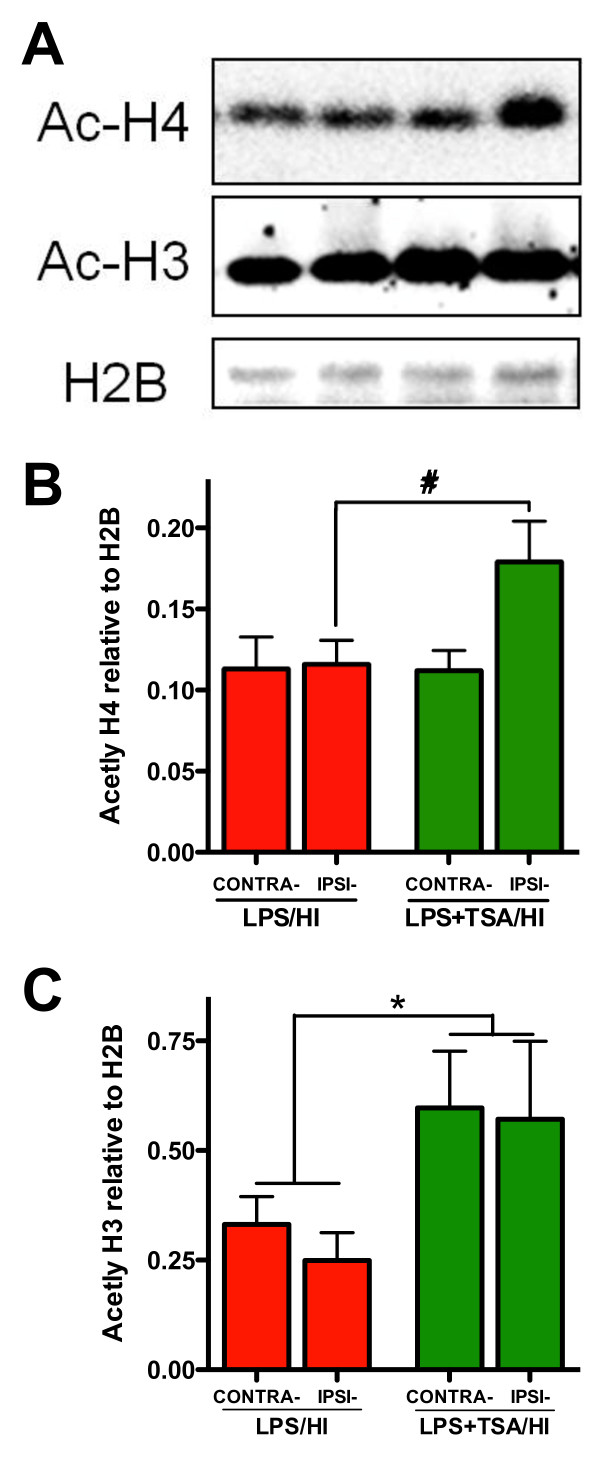
Trichostatin A (TSA) persistently increases histone acetylation at 24 hours after injury. (A) Western blots of acetylated histone-4(Ac-H4), acetylated histone-3 (Ac-H3, molecular weight 17 kDa) and reference protein H2B in female lipopolysaccharide-sensitised hypoxiaischaemia (LPS/HI) mice (red bars) and LPS + TSA/HI mice (green bars) 24 hours after injury. (B) and (C) Mean normalised acetylation data are shown for Ac-H4 (B) and Ac-H3 (C) (all n = 7). Data are means ± SEM. *P<0.05 treatment effect by one-way ANOVA, #P<0.05 by post hoc t-test.